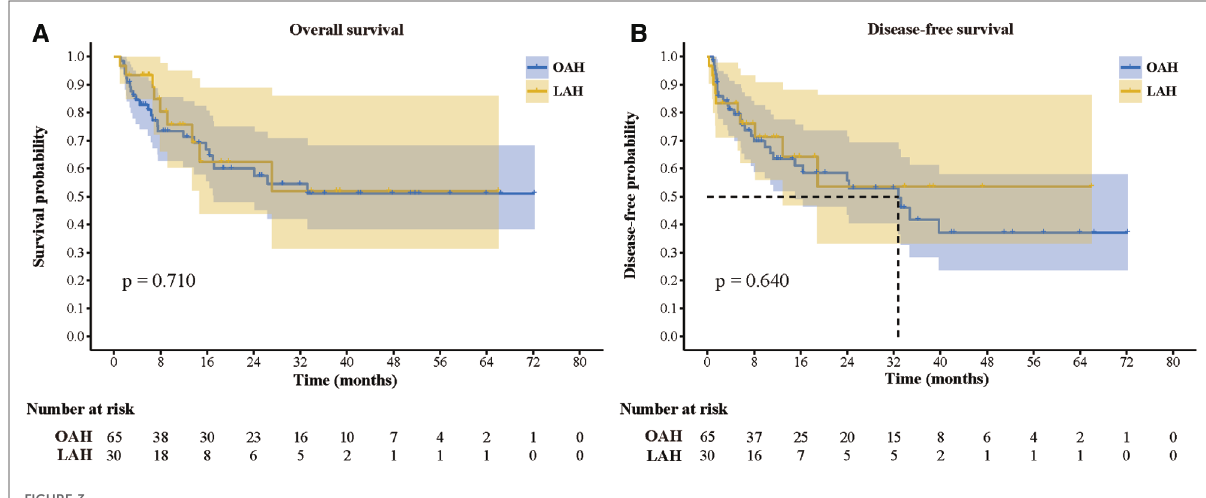
FIGURE 3 Comparison of overall survival and disease-free survival between the two groups. ( A ) Overall survival; ( B): Disease-free